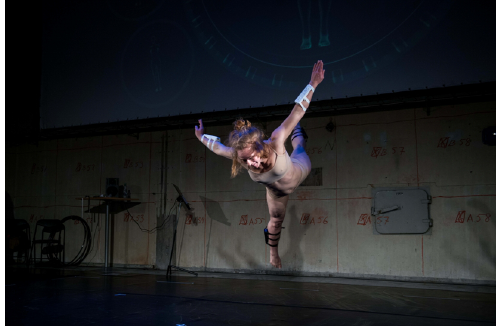
Figure 8. The acrobat in action (Case 3).